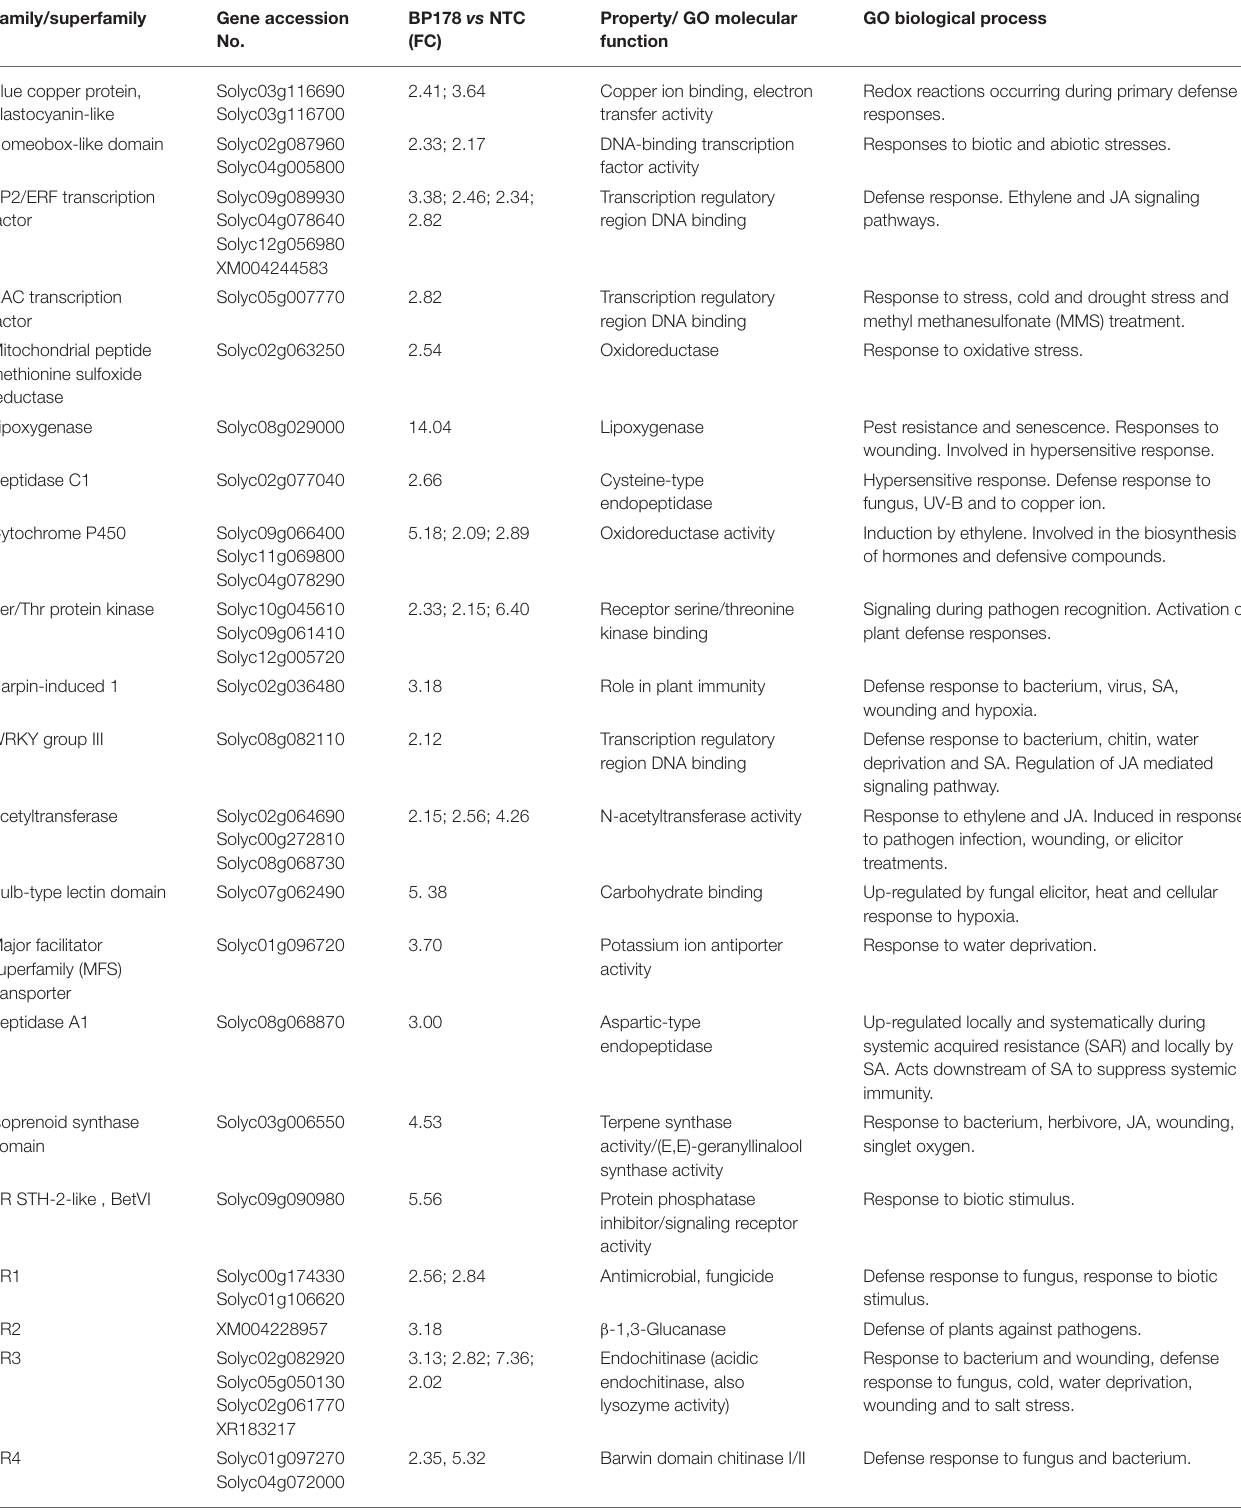
TABLE 3 | Relevant upregulated (2-fold or higher; FDR < 0.05) transcripts after BP178 treatment (125 µ M), identified in this study, associated with plant-defense response (GO term GO:0006952). Family/superfamily Gene accession